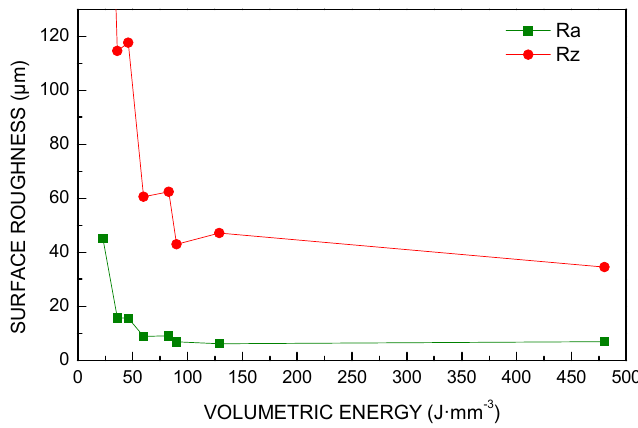
Figure 2. Surface roughness as a function of VED .